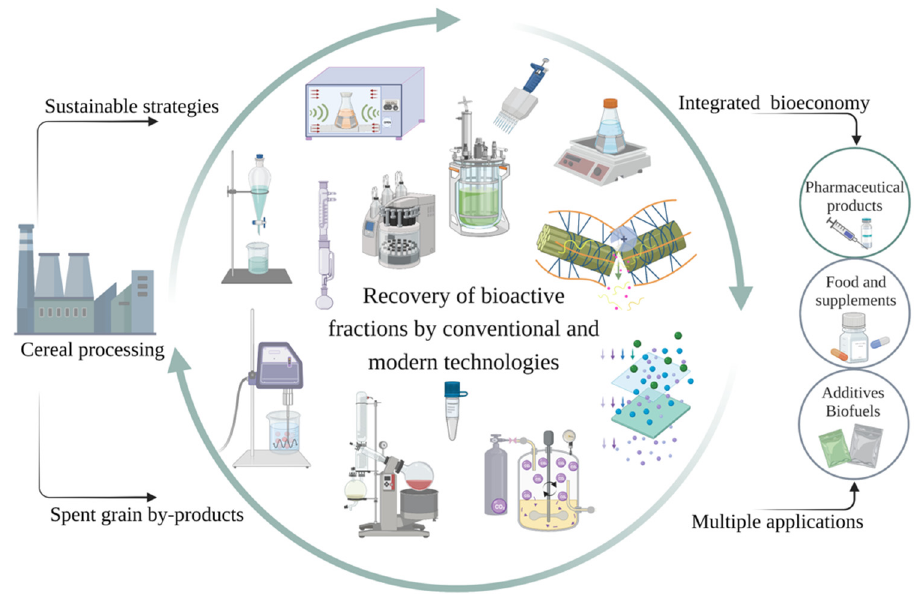
Figure 1. Recovery of bioactive fractions by conventional and modern technologies with different applications.